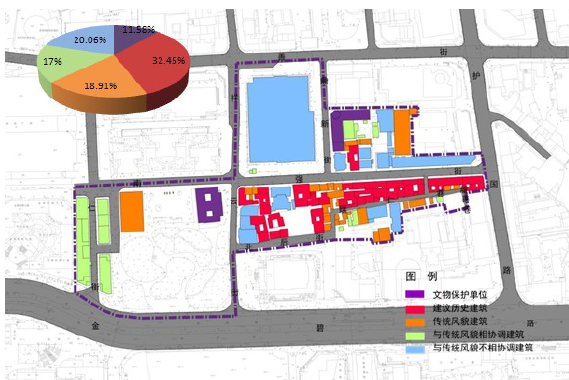
Figure 11. Mapping of Historic Structures of Different